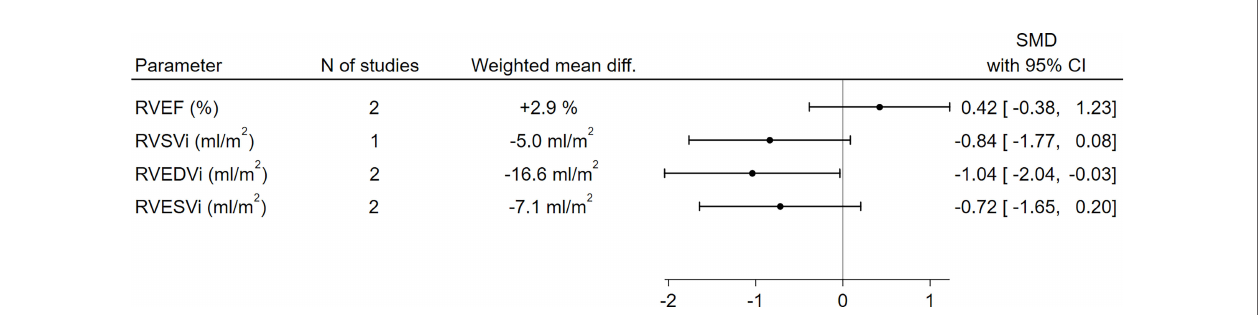
FIGURE 3 | Comparison of RV functional and morphological parameters between patients with GHD and controls. CI, con fi dence interval; GHD, growth hormone de fi ciency; RV, right ventricle; RVEDVi, right ventricular end-diastolic volume index; RVEF, right ventricular ejection fraction; RVESVi, right ventricular end-systolic volume index; RVSVi, right ventricular stroke volume index; N, number; SMD, standardized mean difference.